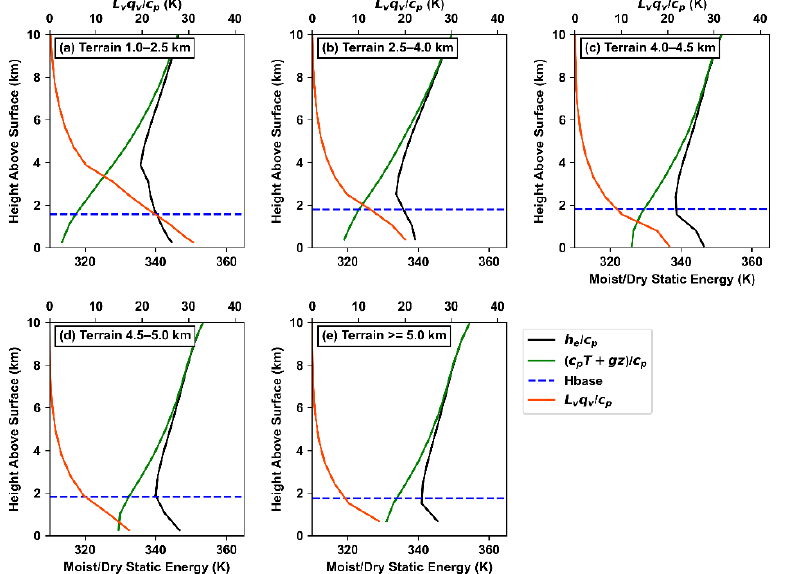
Figure 9. The profiles (height above the surface) of environmental moist static energy (the black line; represented by h e / c p ; units: K; c p is the isobaric specific heat of dry air), environmental dry static energy (the green line; represented as ( c p T + gz )/ c p ; units: K), and environmental latent heat term of water vapor (the orange line; represented as L v q v / c p ; units: K) in different terrain height ranges above 1 km terrain height; the blue line denotes the mean cloud base height; the h e / c p and ( c p T + gz )/ c p use the x -axis at the bottom; the L v q v / c p uses the x -axis at the top.